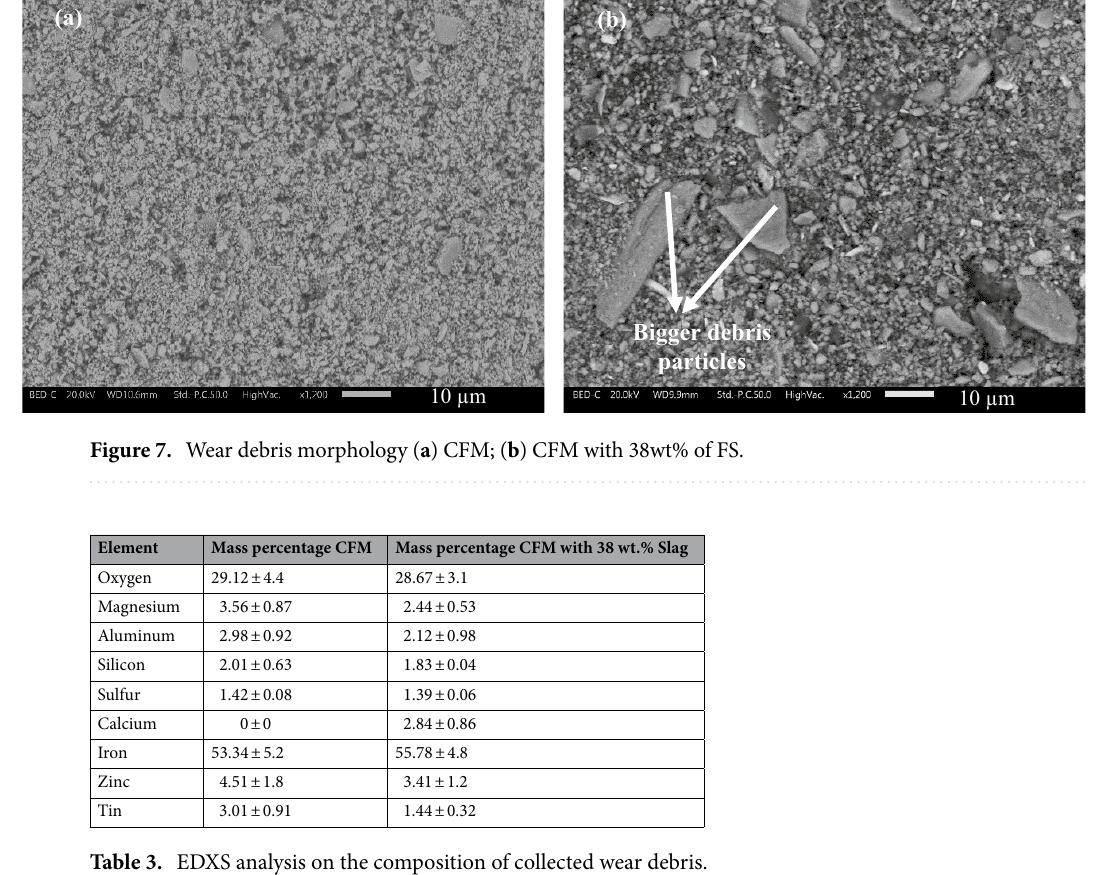
Table 3. EDXS analysis on the composition of collected wear